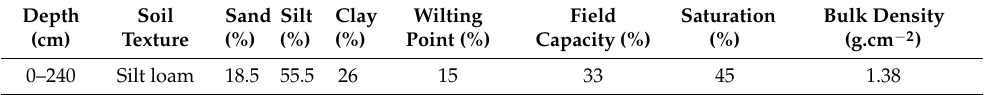
Table 1. The physical characteristics of the soil at the experimental field near Garden City, KS.